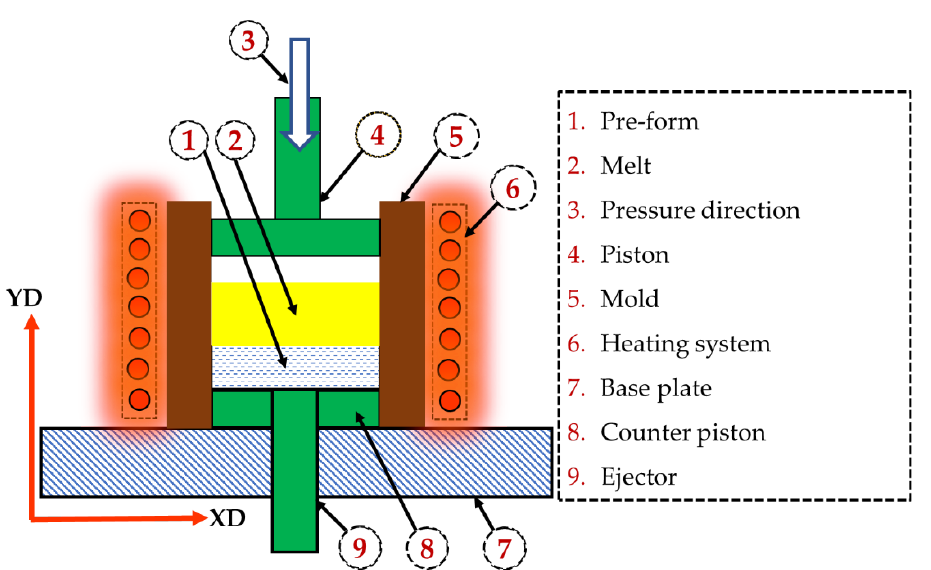
Figure 2. Schematic drawing of the squeeze casting process used in this work, with all items numbered and identified.